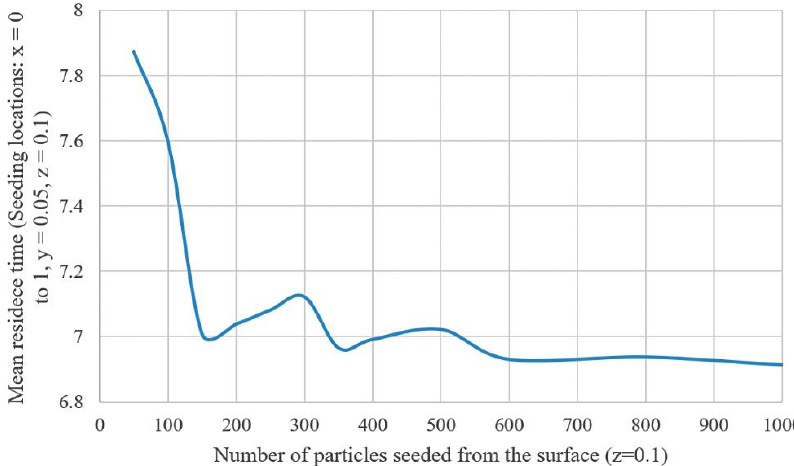
Figure 18. Variation of the mean residence time with the change in number of particles seeded from the model surface.